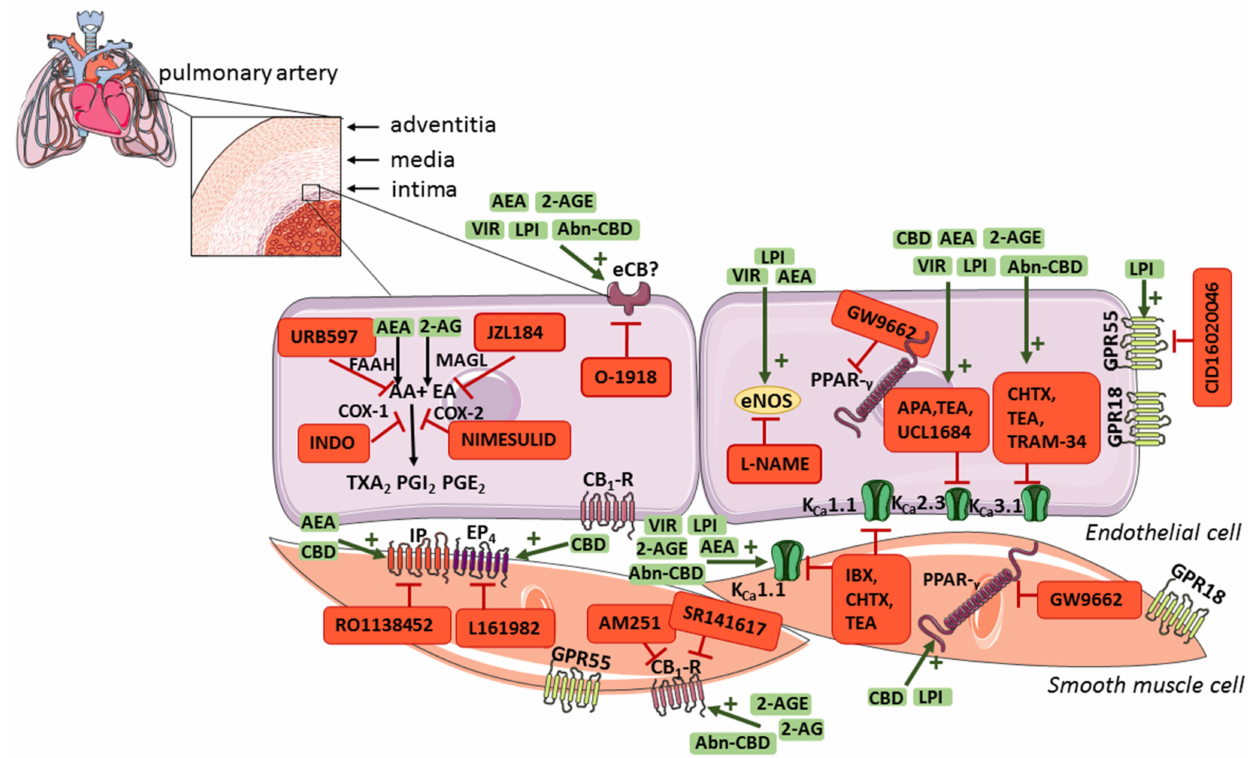
Figure 2. The location of the endocannabinoid system components and potential mechanisms involved in the cannabinoid- induced vasorelaxation in pulmonary arteries. Abbreviations: 2-AG, 2-arachidonoylglycerol; 2-AGE, noladin ether; AA, arachidonic acid; AEA, anandamide; Abn-CBD, abnormal cannabidiol; APA, apamin, K Ca 2.3 inhibitor; AM251, CB 1